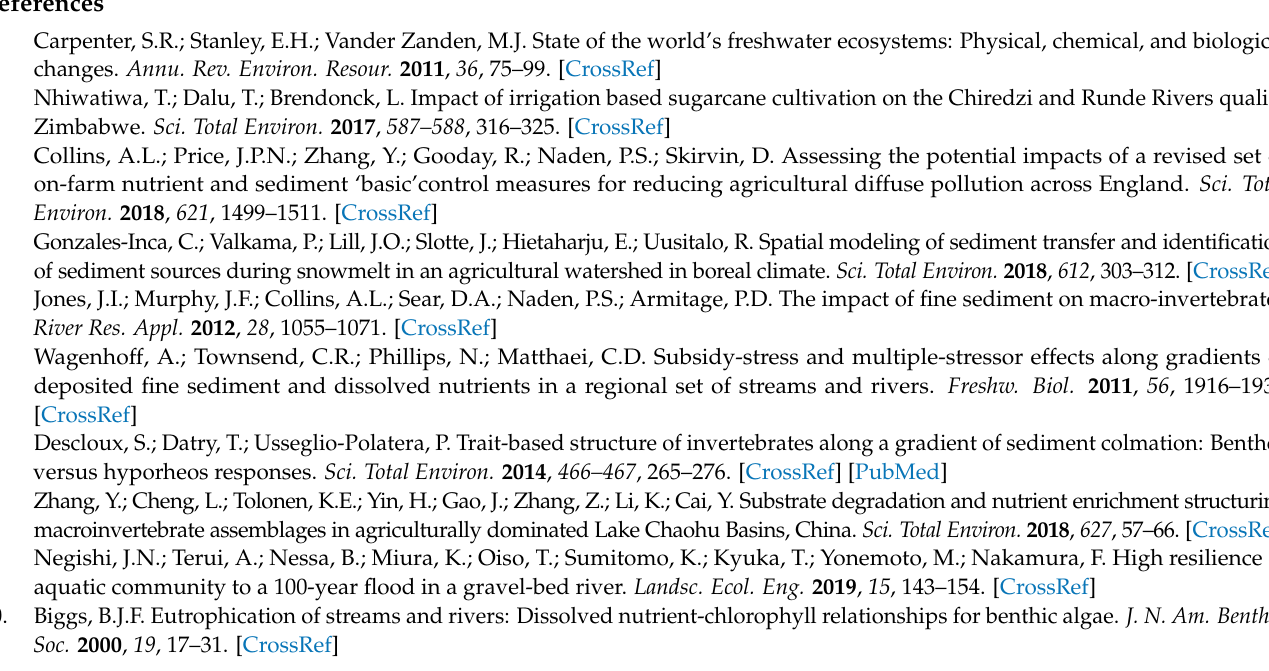
Figure S2: Diagram showing the sampling design of each study site in a longitudinal section of a river; Figure S3: Photos showing how the experimental treatment of sediment addition was conducted; Figure S4: Temporal changes of remaining leaf litter mass (fraction) after the installation (Day 0) in relation to habitat-treatment groups and sites; Figure S5: The relationship between two-week mean water temperature and leaf litter decomposition rate ( k ); Figure S6: The relationship